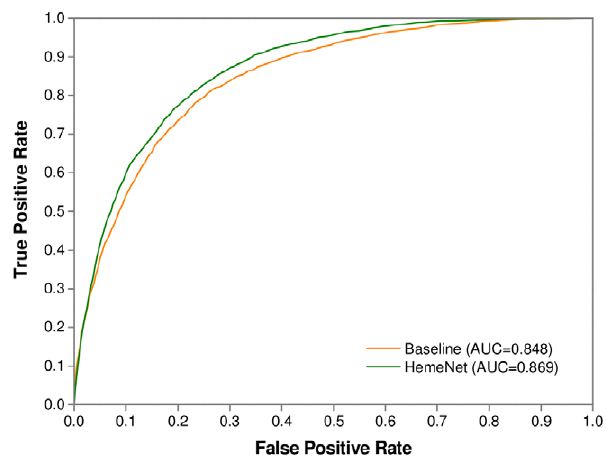
Figure 4. The ROC curves of baseline model and HemeNet tested on Dataset 3. The baseline model was the predictor considering only conventional features, while HemeNet incorporated network-based features into the baseline